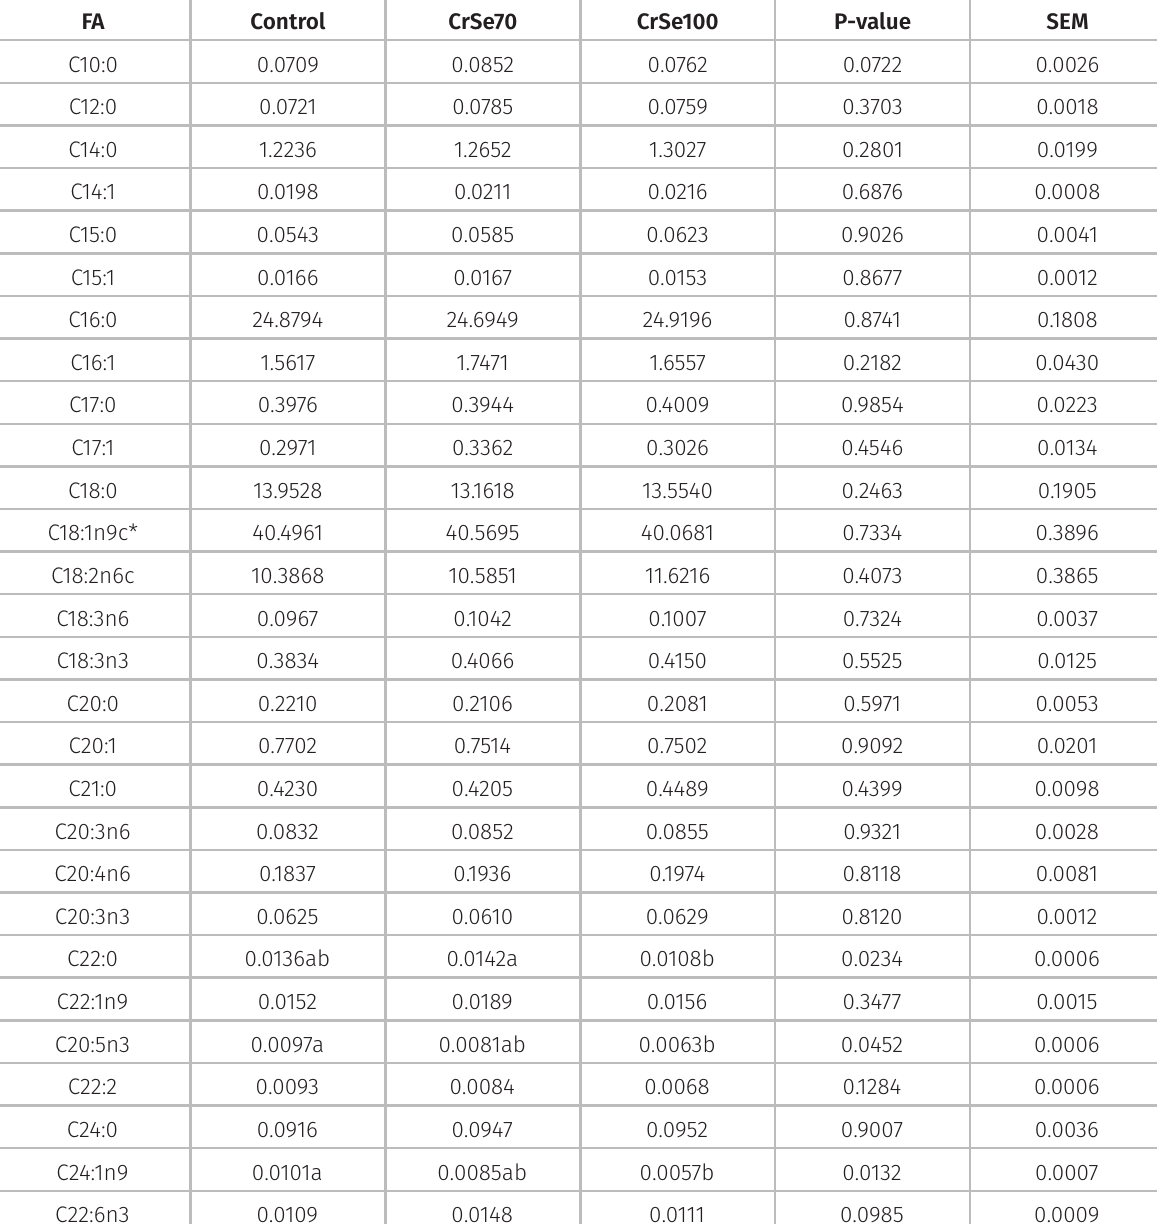
Table IV. Lipid profile (%), of the subcutaneous adipose tissue of swine supplemented with organic chromium and